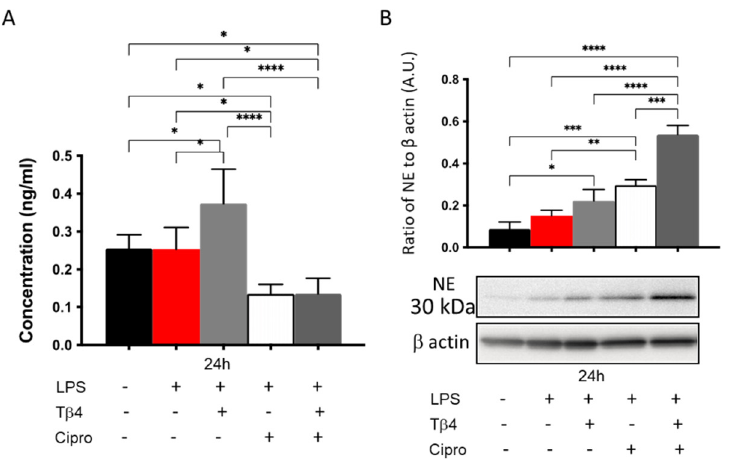
Figure 6. In vitro assessment of NETosis activity in peritoneal-isolated PMN following LPS stim- ulation. Data are shown as mean concentration (ng/mL) of H3 ± SD ( A ) or NE normalized to β -actin ± SD ( B ). Data are representative of three independent experiments. n = 3; * p < 0.05; ** p < 0.01; *** p < 0.001; and **** p <